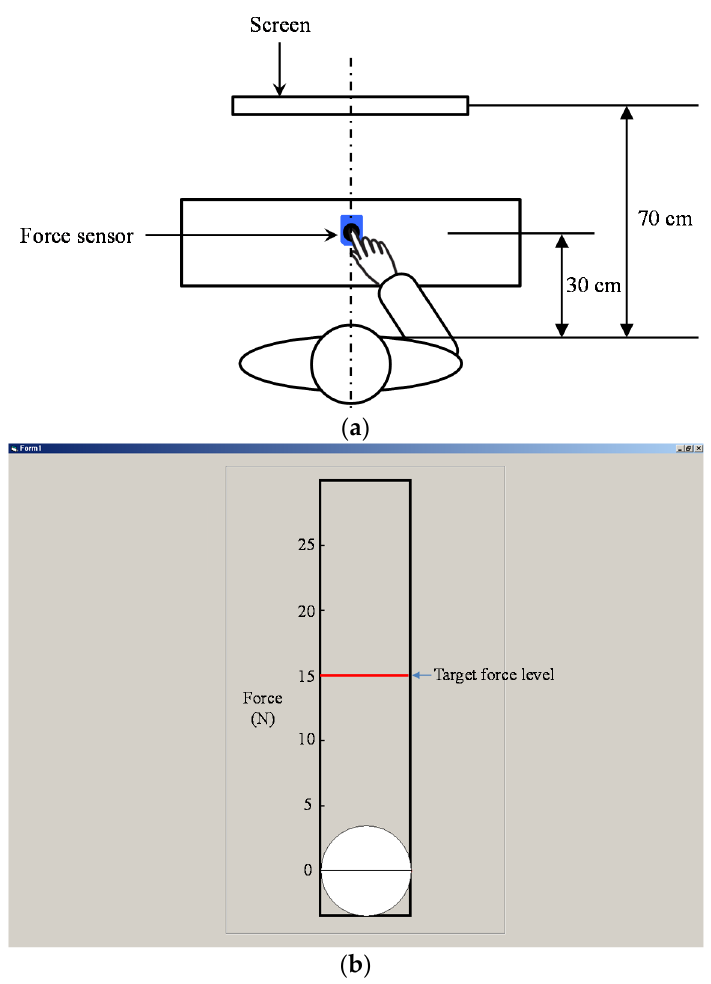
Figure 1. Force tracking system: ( a ) system layout; ( b ) computer screen.